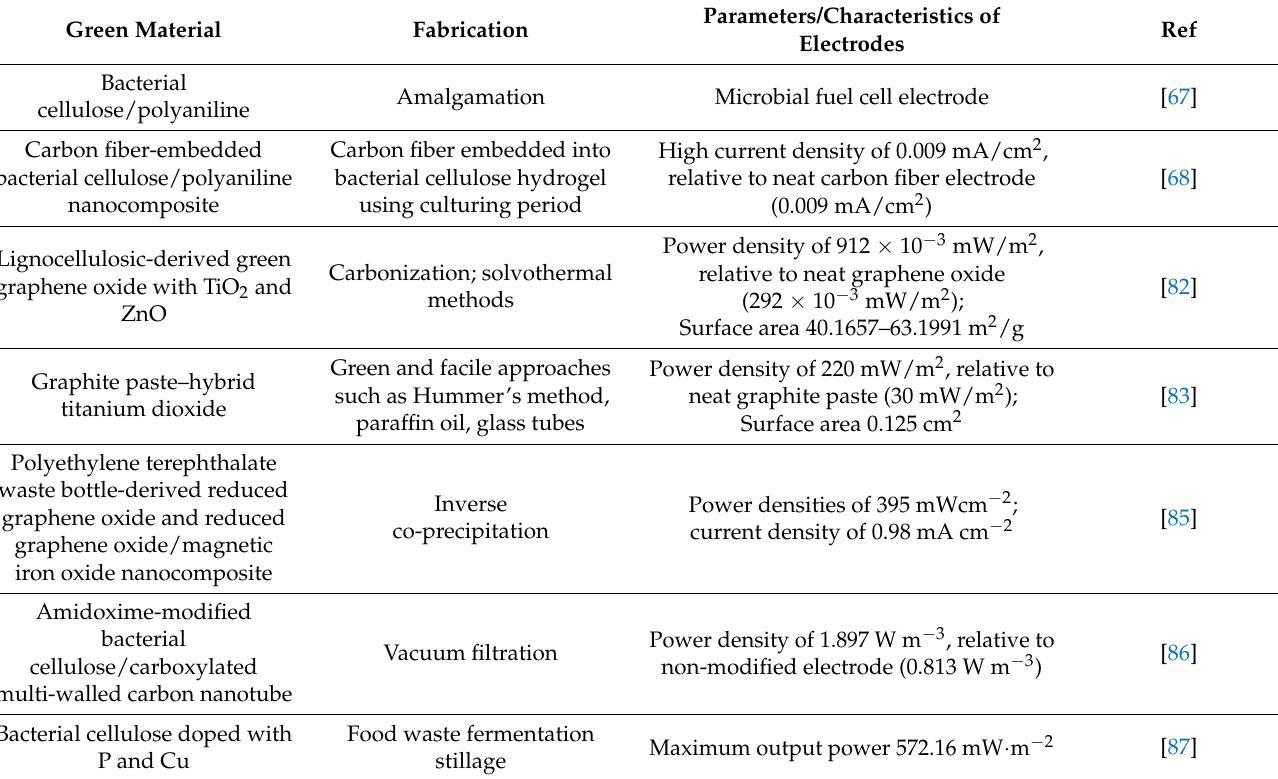
Table 1. Specifications of green nanocomposites for microbial fuel cell electrodes.